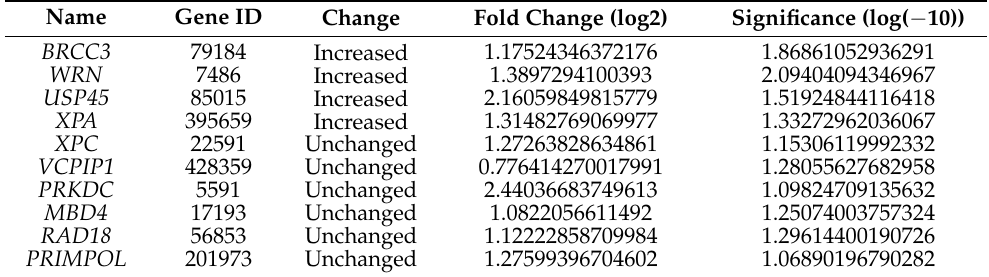
Table 5. Top 10 genes that were enriched in the GSEA gene set for DNA